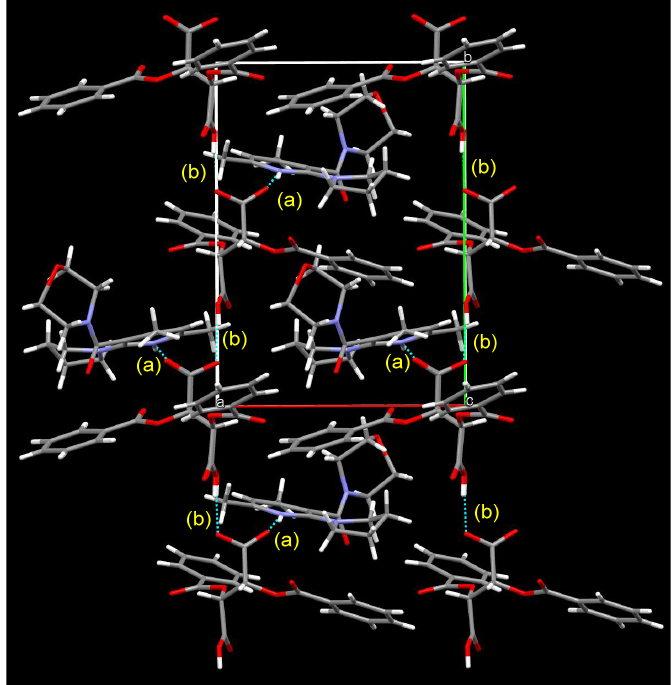
Figure 10. Packing diagram of the chiral salt of (a S )- 1c and ( − )- L -DBTA from the a axis. helix is shown along with the b -axis. Two types of hydrogen bond were observed: A 2 1